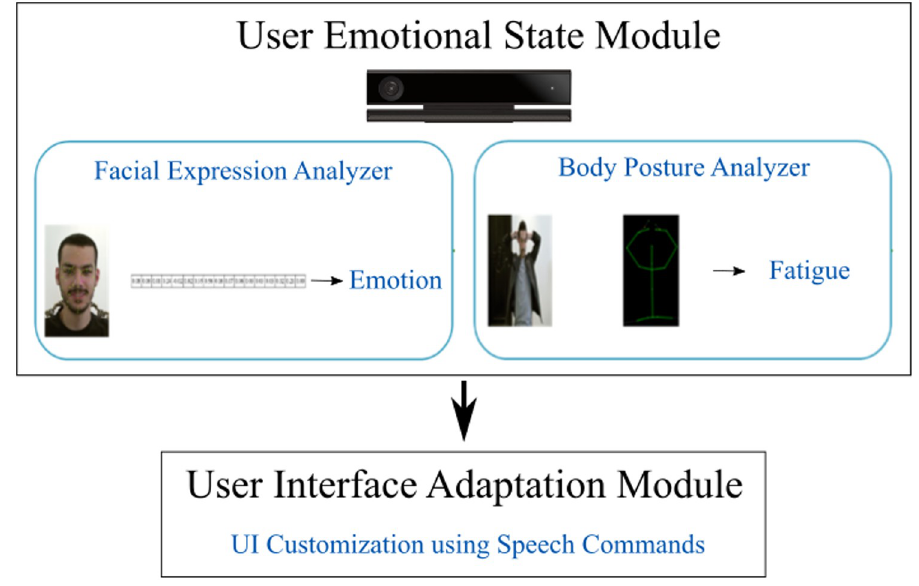
Fig 1. Proposed adaptation framework.